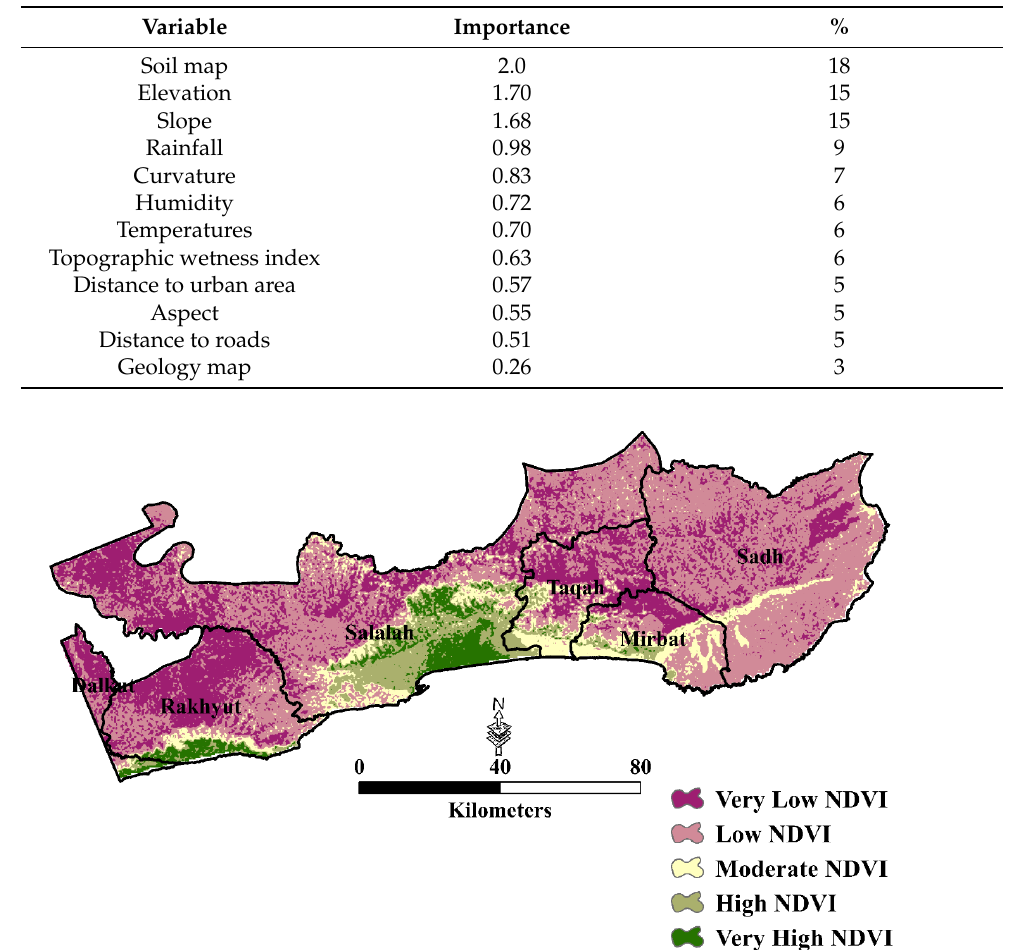
Table 6. Importance of variables in the relationships between NDVIs and combinations of climato- logical, environmental, and human activities factors.